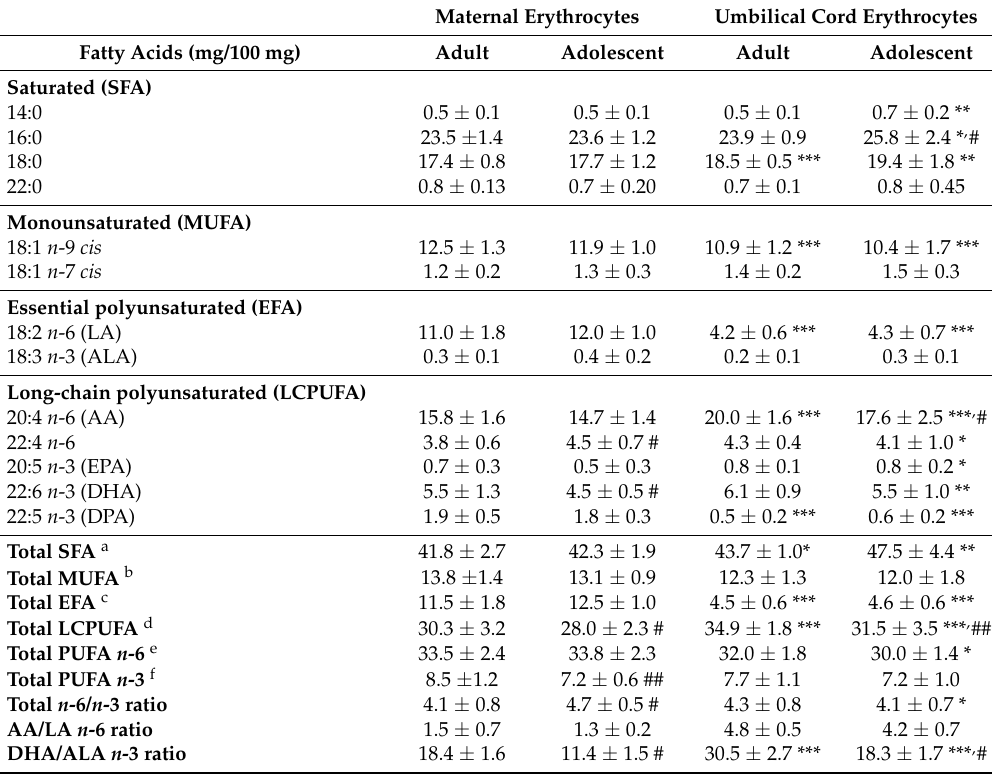
Table 5. Fatty acid composition of maternal and cord blood erythrocytes from adults and adolescents. Maternal Erythrocytes Umbilical Cord Erythrocytes Fatty Acids (mg/100 mg) Adult Adolescent Adult